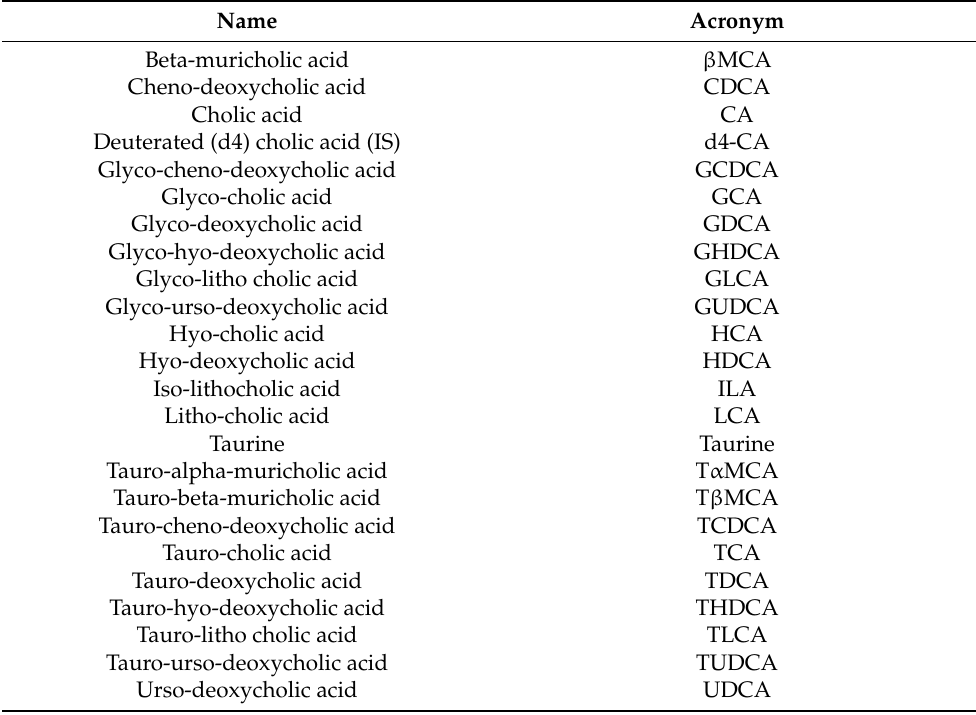
Table 1 outlines bile acid abbreviations and full, common names. Of the 23 bile acid metabolites measured THDCA, β MCA, T β MCA, T α MCA, GDDCA, UDCA, and TUDCA were below the limit of detection. Therefore 16 bile acids were quantified and included in the further analyses. Table 1. Bile acids analyzed using UPLC-MS with the corresponding acronym.